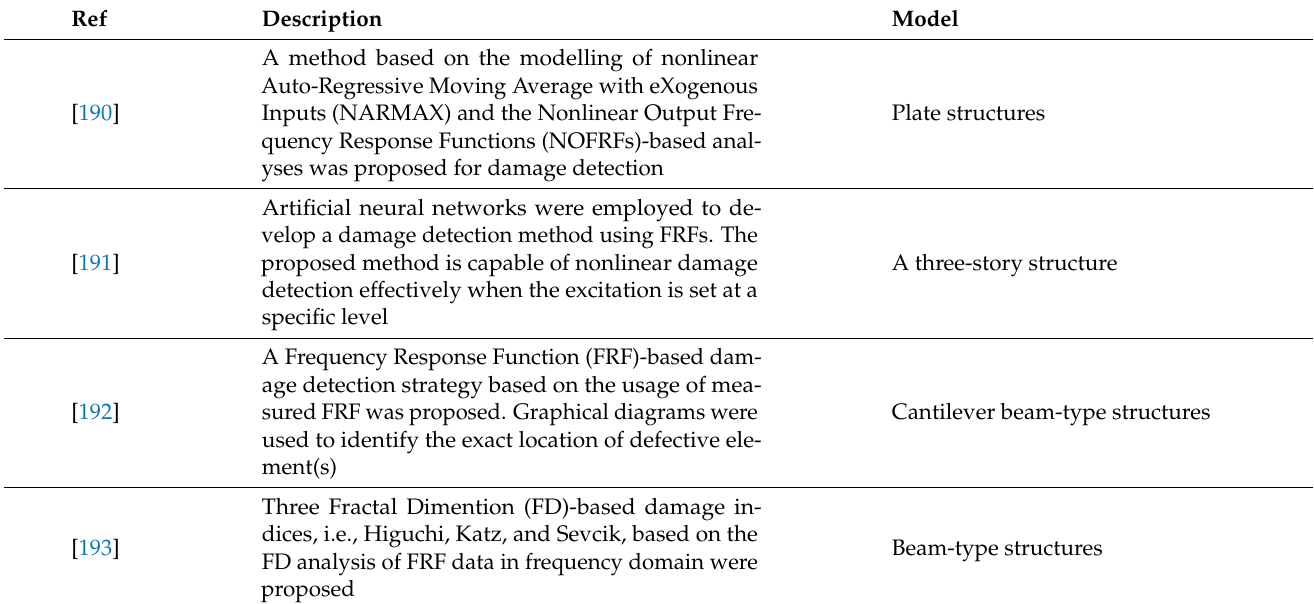
Table 14. Some recent development in applications of FRFs for damage detection in composite